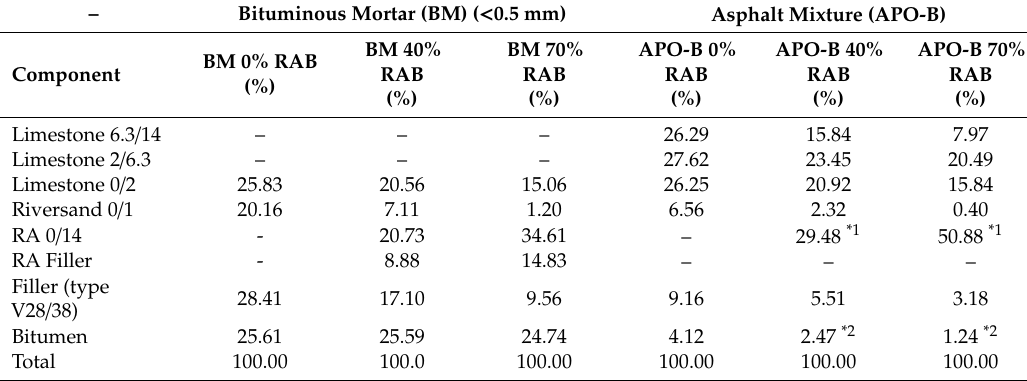
Figure 1. Particle size distribution of the bituminous mortar (BM) and asphalt mixture (APO-B) designs for the three reclaimed asphalt binder (RAB) replacement rates: 0%, 40%, and 70% RAB. Table 1. Fractional composition of the three bituminous mortar and APO-B mixtures for the three replacement rates: 0% RAB, 40% RAB, and 70% RAB.